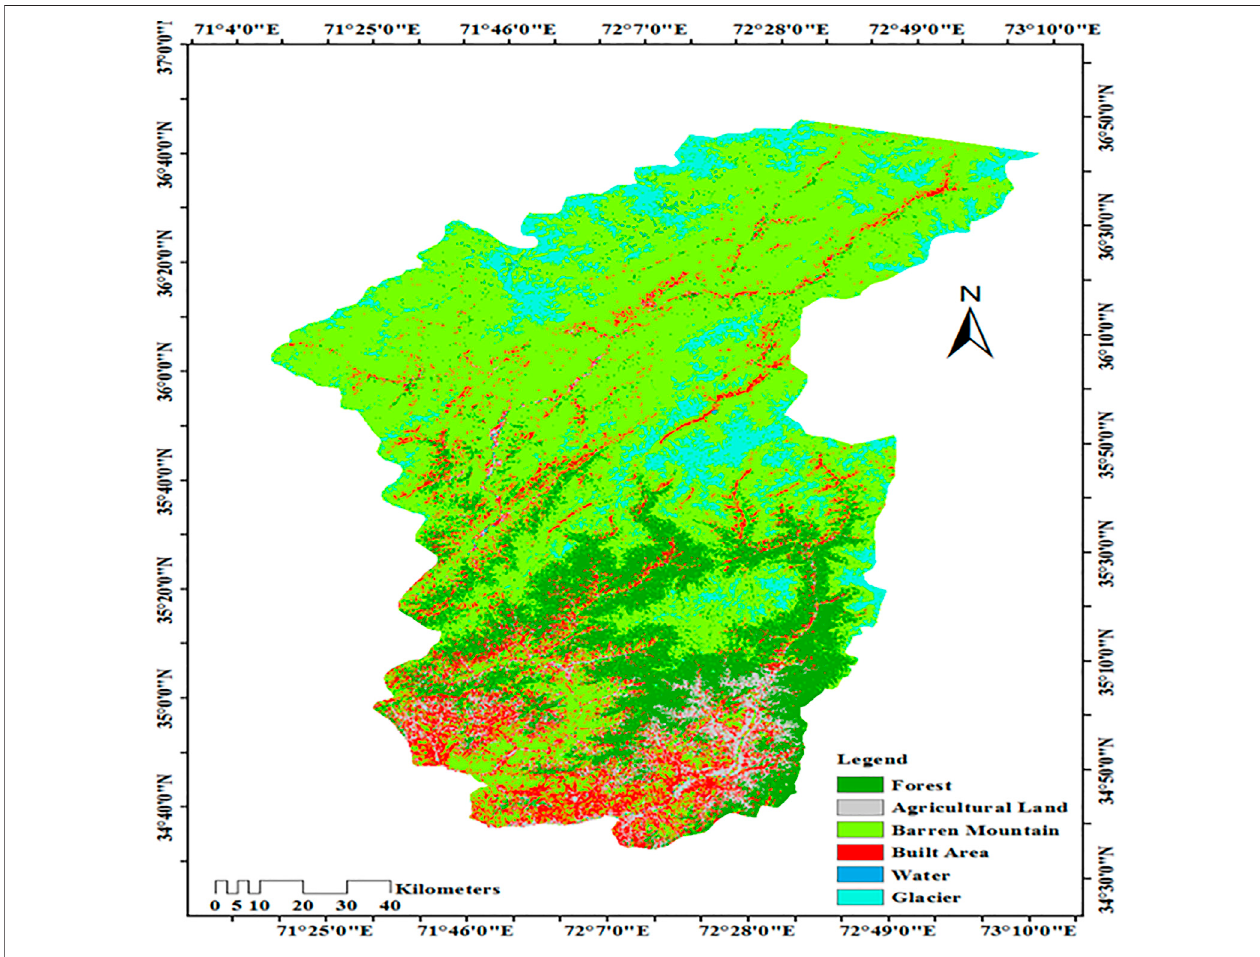
FIGURE 2 | Land use map of the year